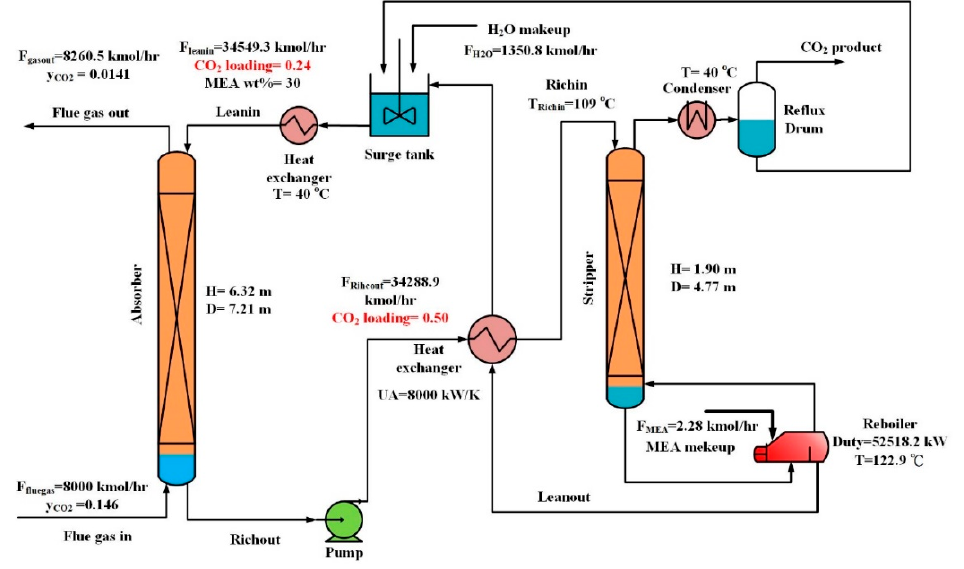
Figure 1. The CO 2 capture process using monoethanolamine (MEA) solvent for a coal-fired power plant.